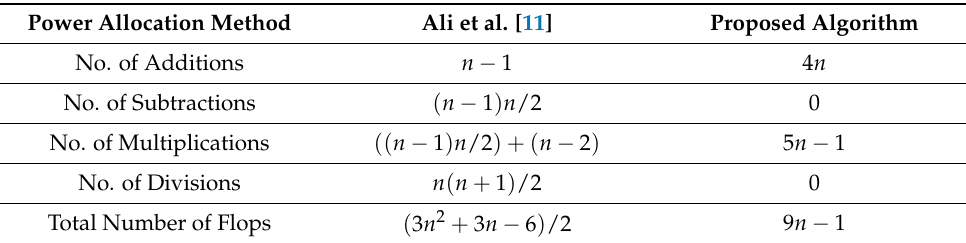
Table 2. Complexity comparison in flop